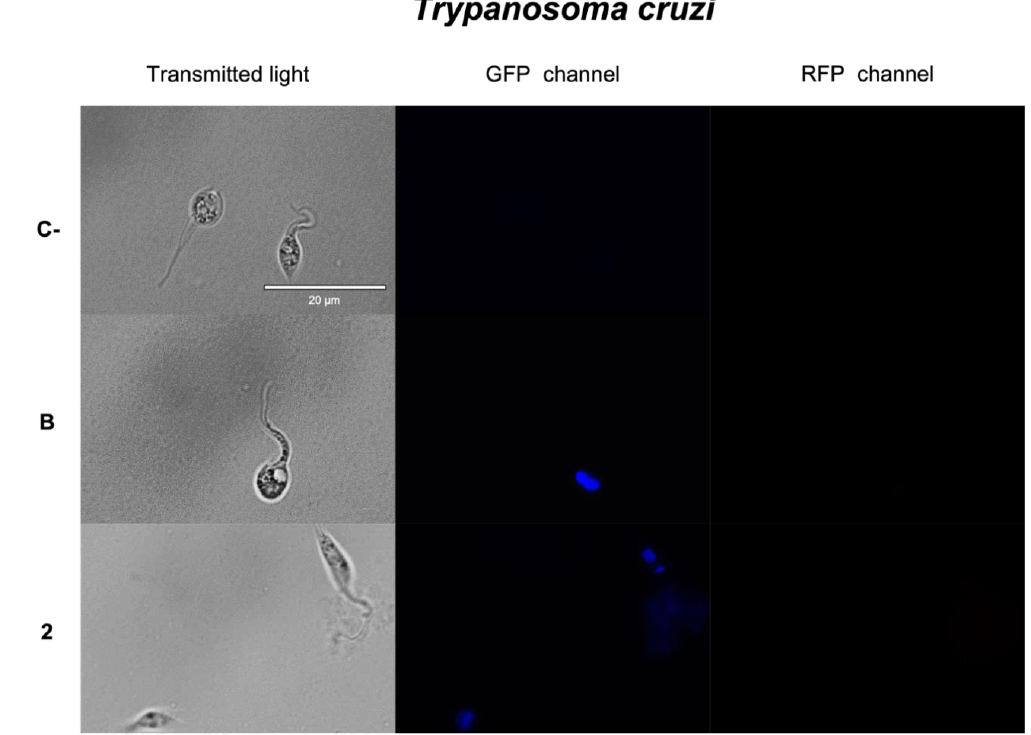
Figure 2. Detection of chromatin condensation by Vybrant ® Apoptosis Assay Kit n°5, Hoechst 33342/Propidium Iodide. The images represent promastigotes of L. amazonensis after 24 h of incubation with the IC 90 of 4 β -hydroxyarbusculin A ( 11 ) and anhydroartemorin ( 2 ), promastigotes of L. donovani after 24 h of incubation with the IC 90 of cis,trans -costunolide-14- acetate ( 3 ) and epimastigotes of T. cruzi after 24 h of incubation with the IC 90 of anhydroartemorin ( 2 ). Parasites without any treatment were used as negative control ( C- ), and miltefosine ( M ) and benznidazole ( B ) were used as reference treatments against Leishmania spp. and Trypanosoma cruzi , respectively. Pictures were captured by using an EVOS FL Cell Imaging System (100×). Scale bar: 20 μm.